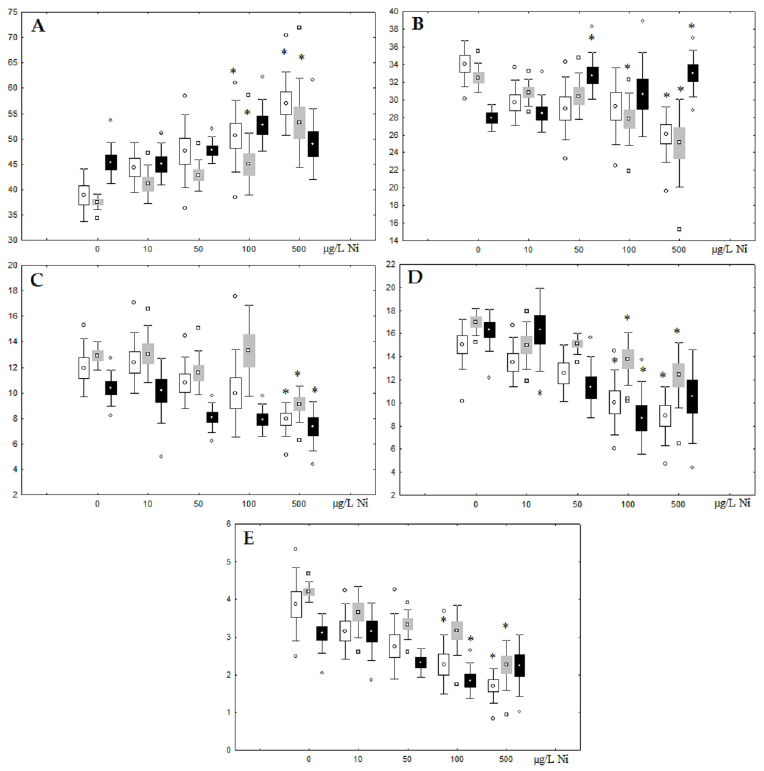
Figure 3. Changes in the ( A ) sum of saturated fatty acids, ( B ) monounsaturated fatty acids, ( C ) n-3 polyunsaturated fatty acids, ( D ) n-6 polyunsaturated fatty acids, and ( E ) unsaturation index in phospholipids of digestive glands of A. cygnea under experimental nickel effects: white box—day 1 of the experiment; grey box—day 3 of the experiment; black box—day 7 of the experiment. *—significant results in comparison with control (0 µ g/L Ni). Differences were estimated using the nonparametric Kruskal – Wallis test; p < 0.05.